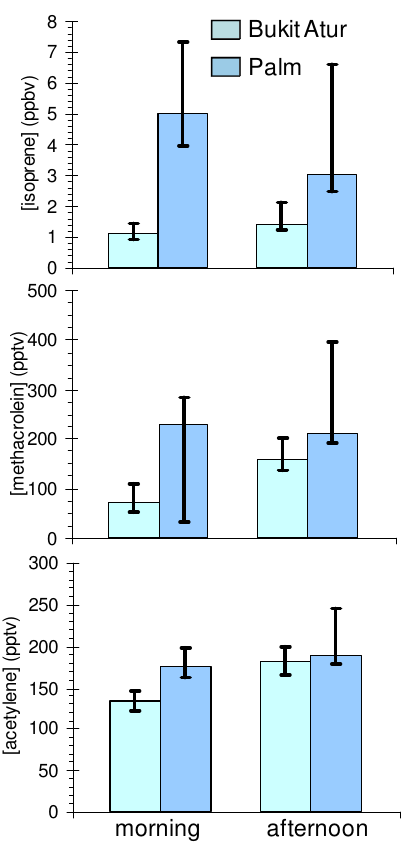
Figure 9. Mean mixing ratios of isoprene, methacrolein and acetylene (with range expressed as 25th and 75th percentiles) observed within the boundary layer (<500 ft) above the Danum Valley natural rainforest in the vicinity of the Bukit Atur site, and over the oil palm plantations. The particularly large range of isoprene and methacrolein mixing ratios at both locations reflects the substantial diurnal variability in ambient levels of these gases.